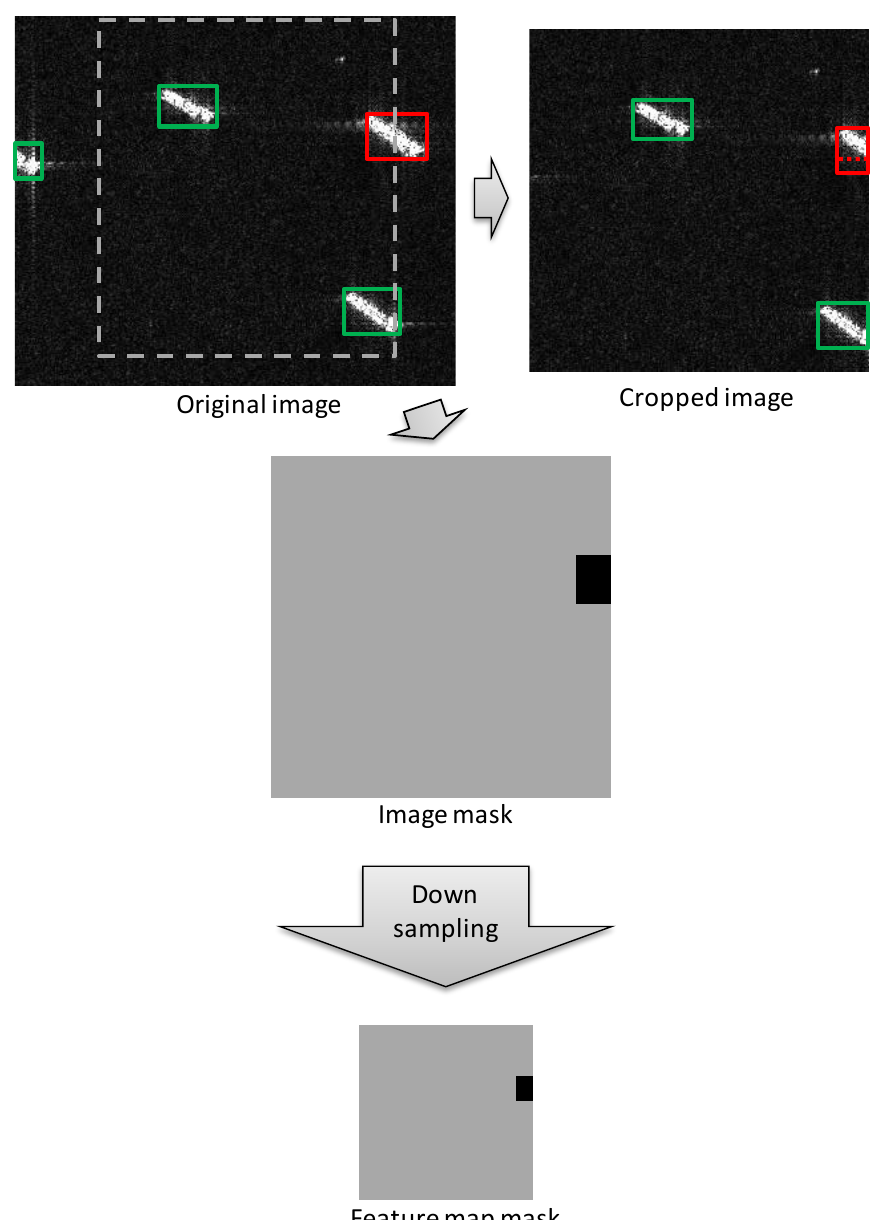
Figure 4. Three training samples of synthetic aperture radar (SAR) ship detection (left column) and examples of their random cropping results (right column). ( a ) Sample of small size targets. ( b ) Sample of medium size targets. ( c ) Sample of large size target.